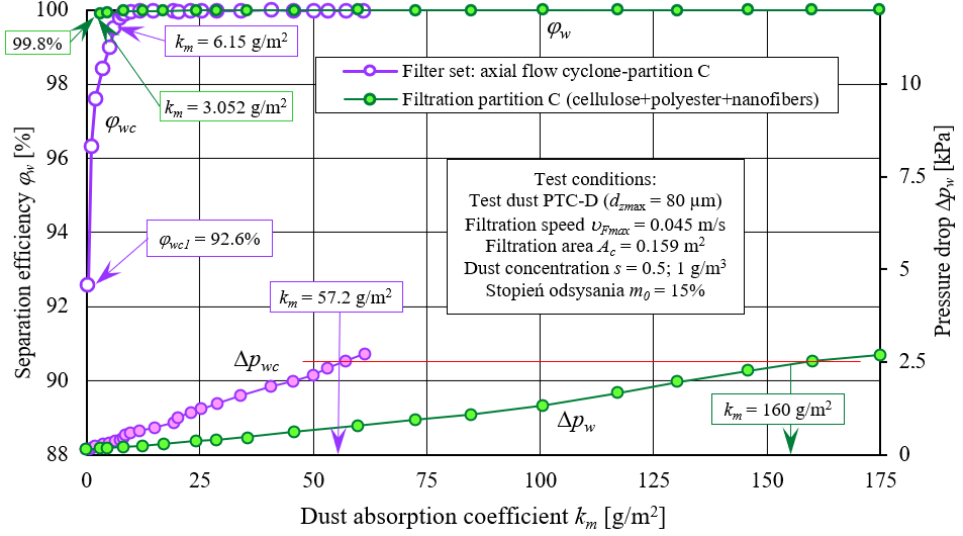
Figure 16. Characteristics: separation efficiency ϕ w = f ( k m ) and pressure drop ∆ p w = f ( k m ) as a function of dust absorption coefficient k m of filter material C working in the “filter set” as the second filtration stage (after through cyclone) and in a single ‐ stage system—cyclone barrels.